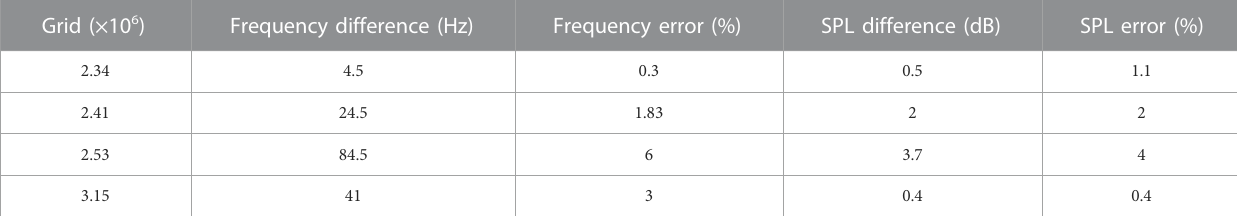
TABLE 1 The effect of the grid on the acoustic results.